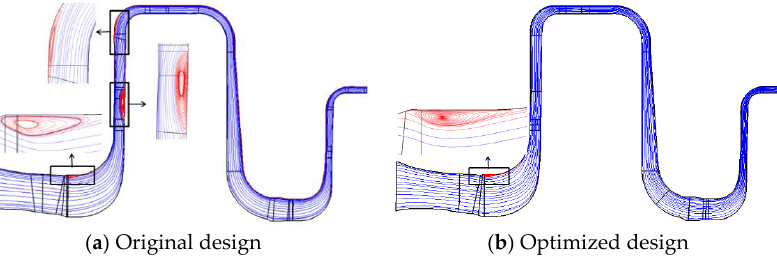
Figure 20. Meridional streamline at 60% load.